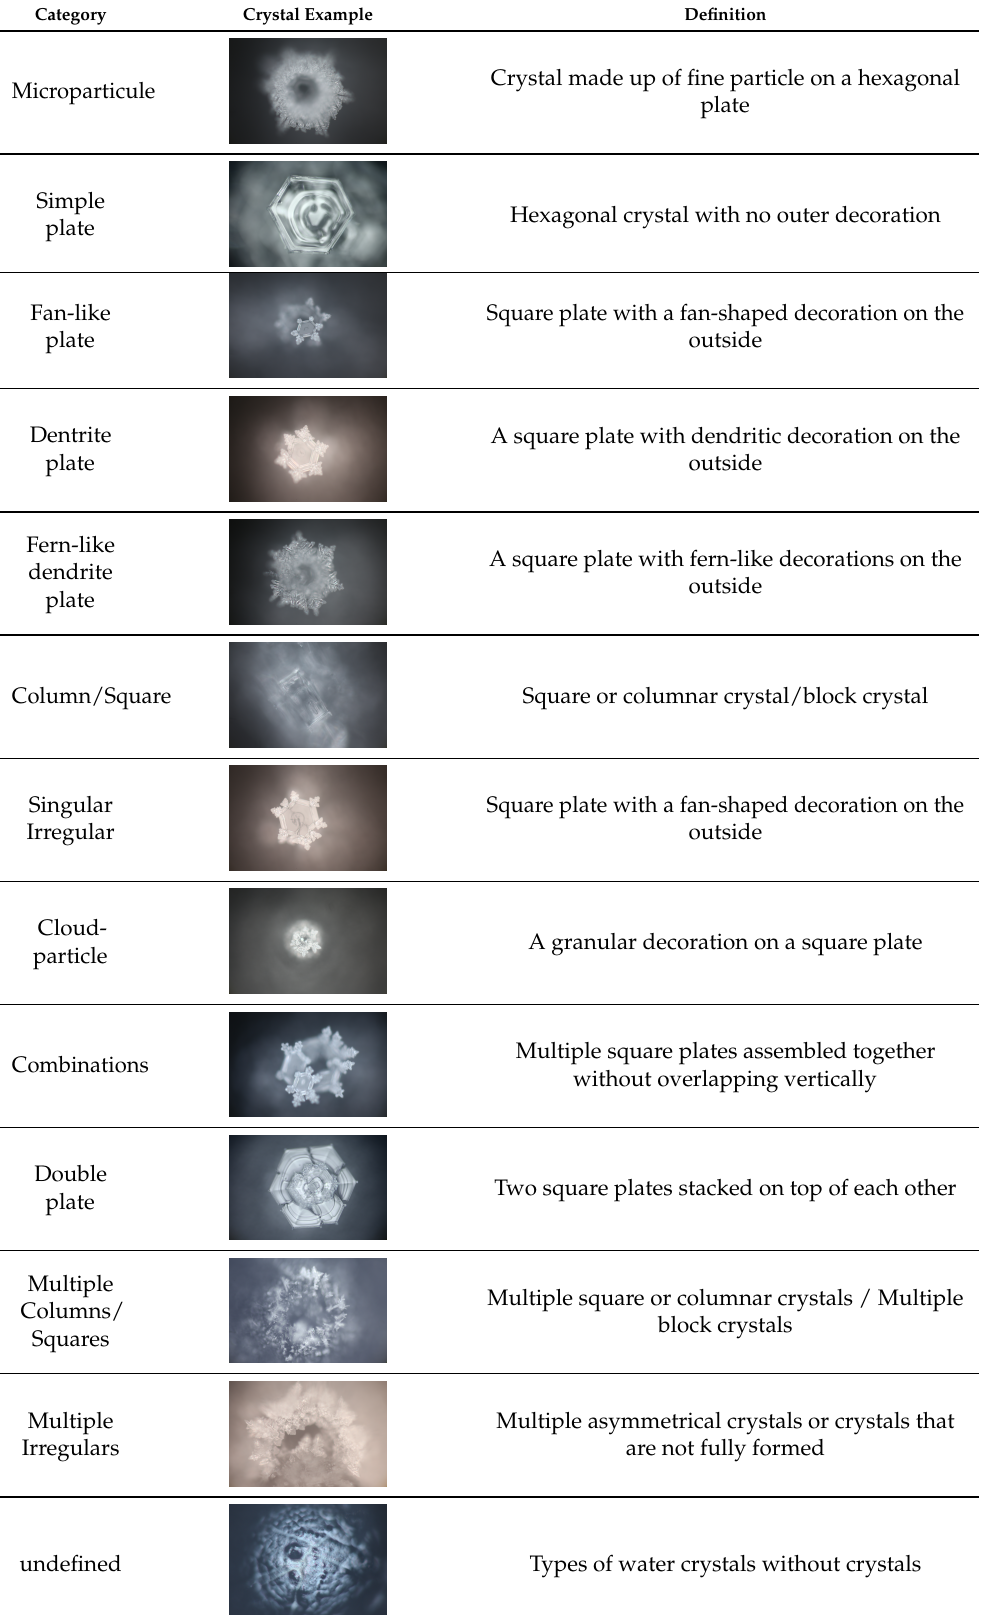
Table 1. The definition for water crystal classes based on the knowledge from [5]